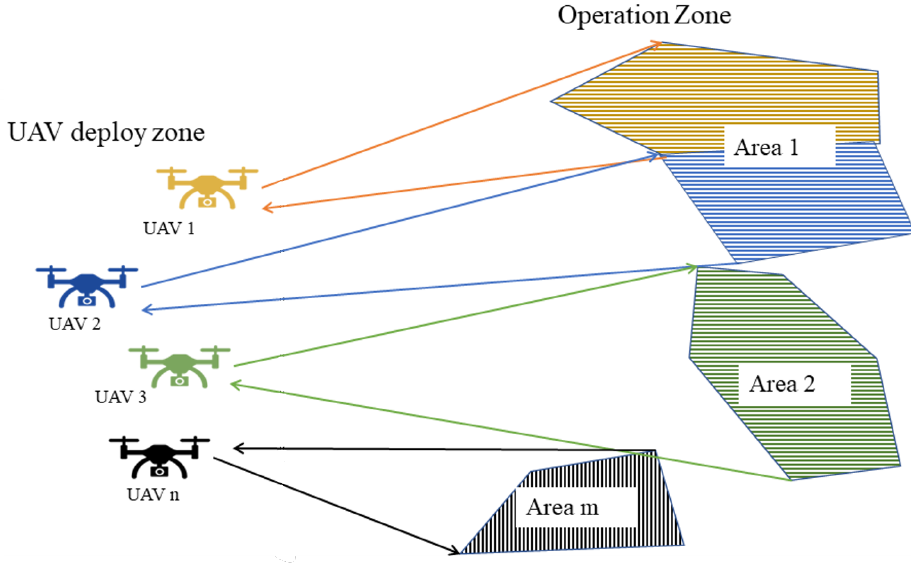
Figure 3. Mission operation